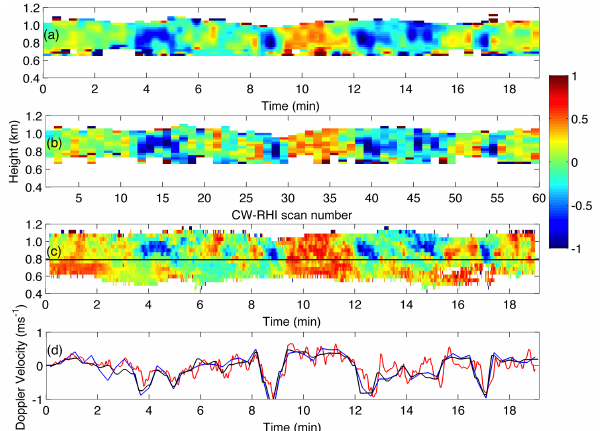
Fig. 10. Schematic of Ka-SACR CW-RHI Doppler velocity obser- vations. Identified are the elevation angle ( θ) , the horizontal wind projection on the radar scan plane ( V H , RHI ) , the vertical Doppler velocity ( V D , V ) and the observed angular Doppler velocity ( V D ,θ )